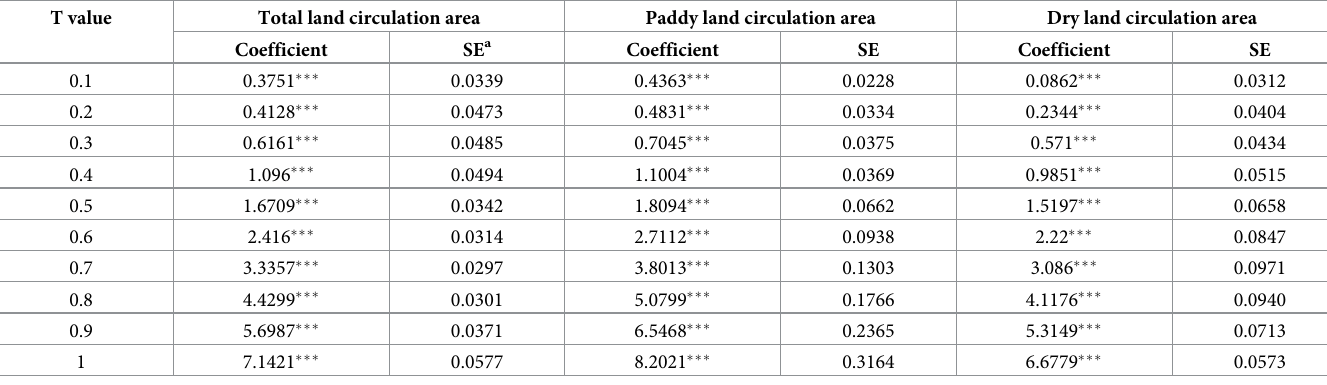
Table 5. GPSM treatment effect estimation results of agricultural planting structure by land circulation